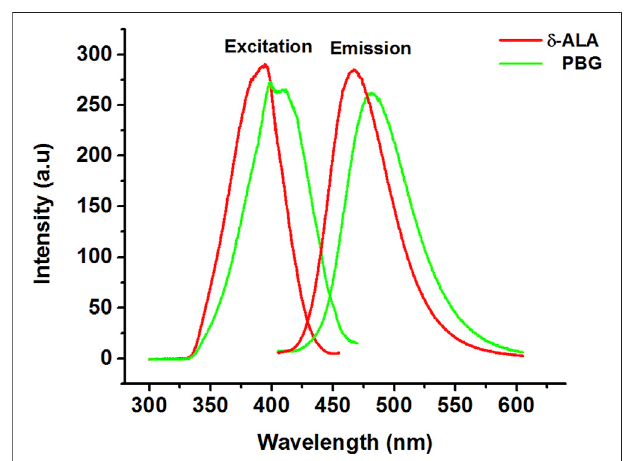
FIGURE 1 | Excitation and emission spectra of δ -ALA (2.5 μ mol L − 1 , red solid lines, λ ex = 394.4 nm; λ em = 467.3 nm) and PBG (6.5 μ mol L − 1 , green solid lines, λ ex = 399.7 nm; λ em = 481.6